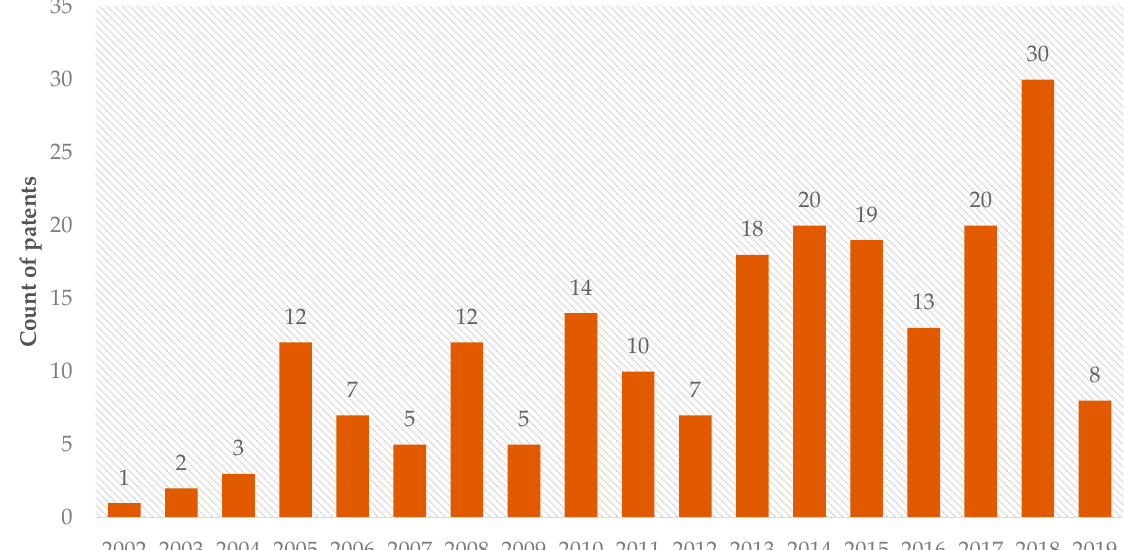
Figure 3. Patents issued on the use of silver nanoparticles in dentistry by year of publication. The USA is still the country with the highest protection, showing a trend in the mar- ket and the pharmaceutical industry to use this technology. Protection also occurs in China, India, Canada, and Brazil (Figure 4).